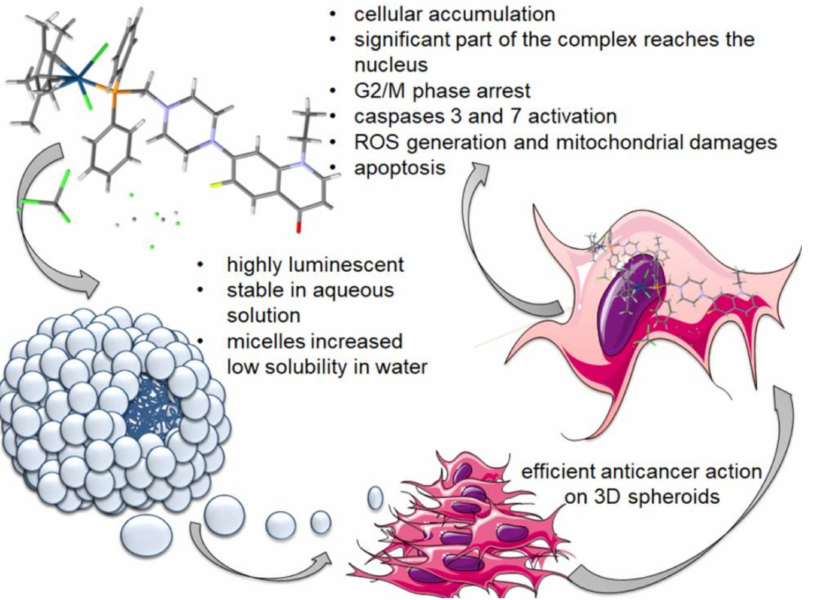
Figure 1. Scheme of cytotoxic action mechanism of Ir(III) complexes described by our group in a previous paper (Kozieł, S. et al., Inorganic Chemistry Frontiers, 2020, 7,